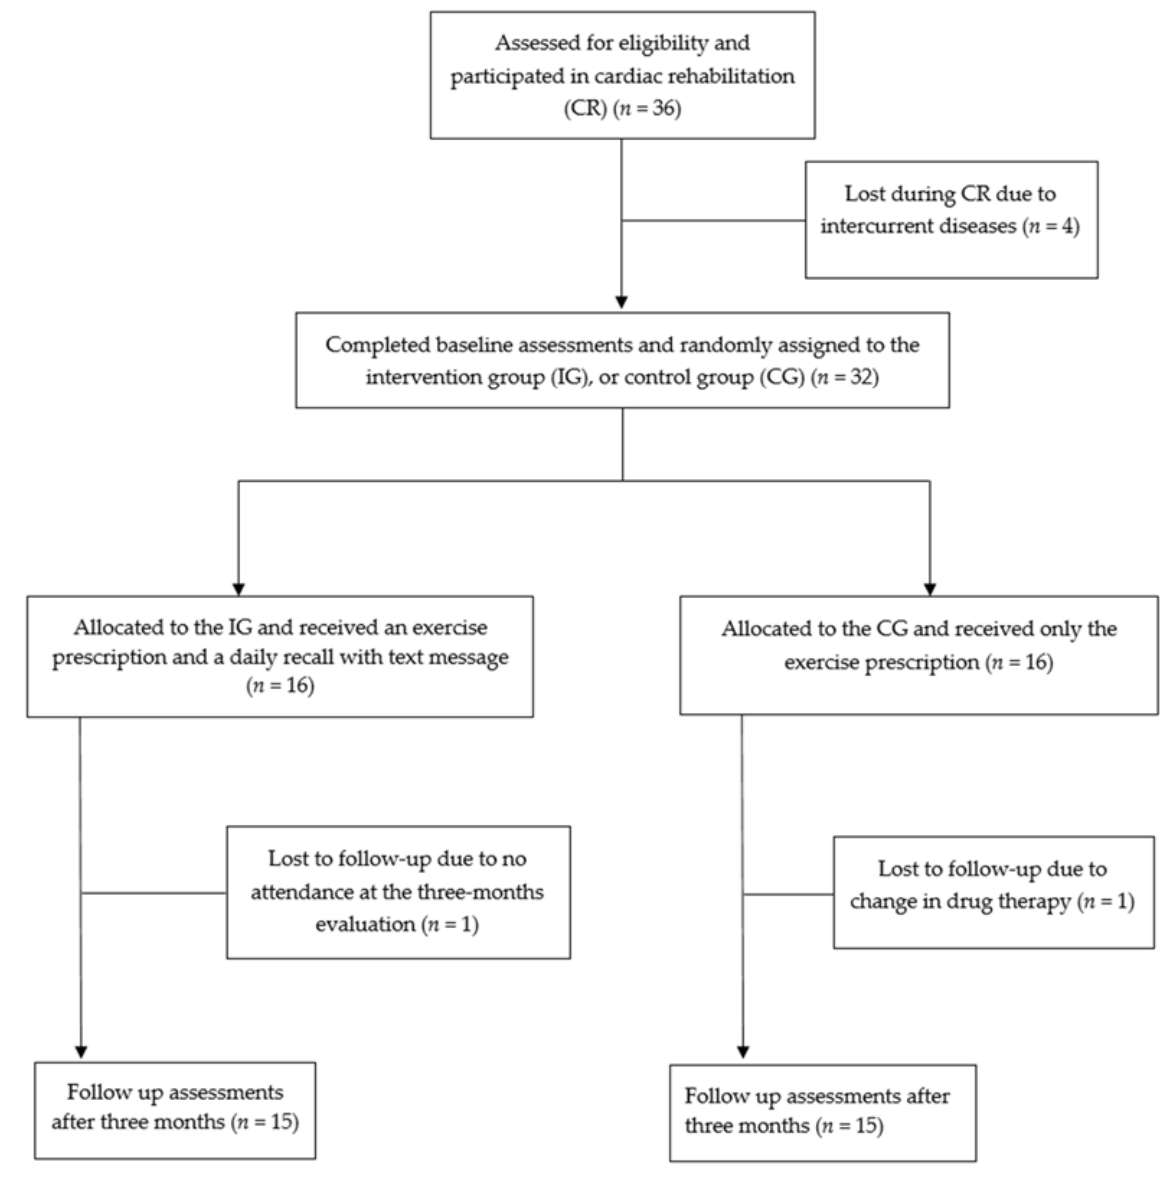
Figure 1. PRISMA flow